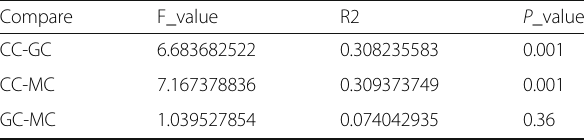
Table 3 Weighted_unifrac anosim analysis Compare R_value P _value CC-GC 0.571861472 0.001 CC-MC GC-MC